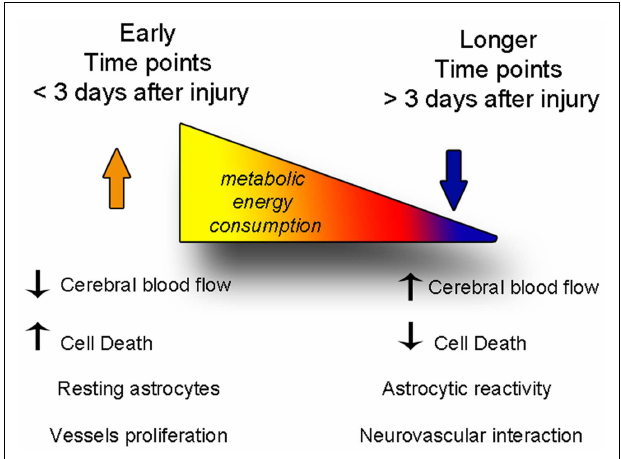
FIGURE 6 |The balance between degenerative and vascular phenomena is altered with time after injury . At early time points, cell death and decreased cerebral blood flow predominate, while astrocytes are not yet reactive. At later time points, cerebral blood flow levels are restored fewer cells die, but astrogliosis becomes stronger, and the neurovascular units